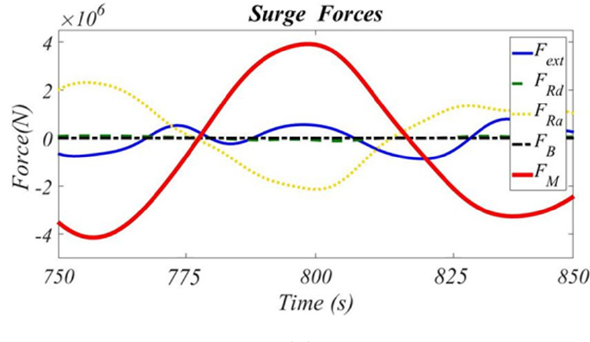
21 ( c ) Figure 17. The performance of ( a ) surge, ( b ) heave, and ( c ) pitch RAOs as a function of wave frequency for the UMaine-Hywind spar by comparing hydrodynamic simulator with experimental data of NOEL. According to the Boundary Element Method (BEM) [34], proximity to a boundary can have the influence on the quantity of hydrodynamic coefficients. This means that added-mass and radiation damping coefficients not only depend on the floater’s geometry but also its proximity to a boundary. For floating bodies, the response of the floating body is altered in finite water depth. The specific water depth at which the hydrodynamic coefficient is affected depends on the floater’s geometry, location and shape of a boundary, e.g. the seabed. Therefore, the water depth may have the effects